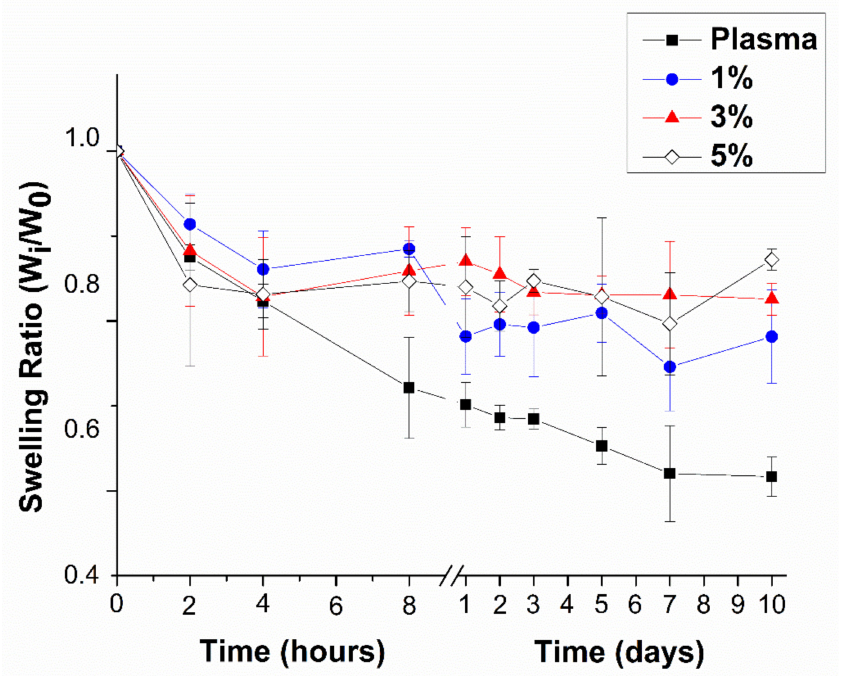
Figure 4. Plasma and hybrid plasma-SKSs contraction, determined as mass loss for 10 days, in PBS, pH 7.4, at 37 ◦ C for each gel composition (n = 3). Data reported as mean ± SD. Percentages indicate % w / v elastin content in hybrid